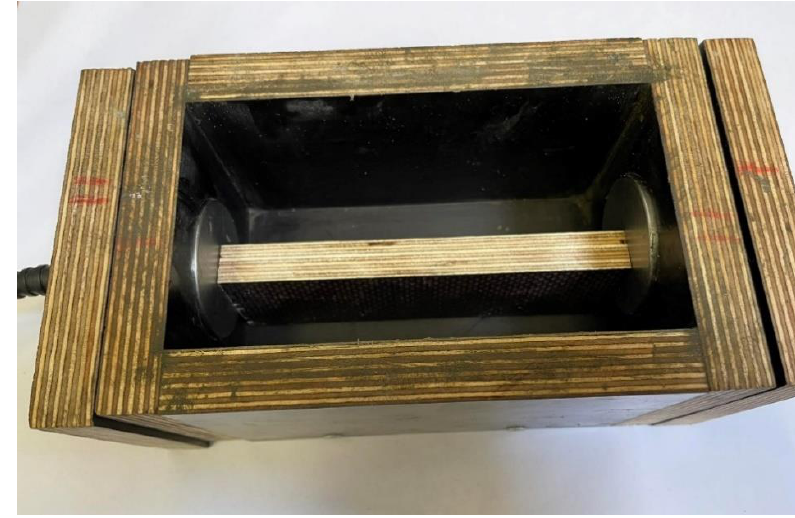
Figure 4. Empty cell with ultrasonic probes.